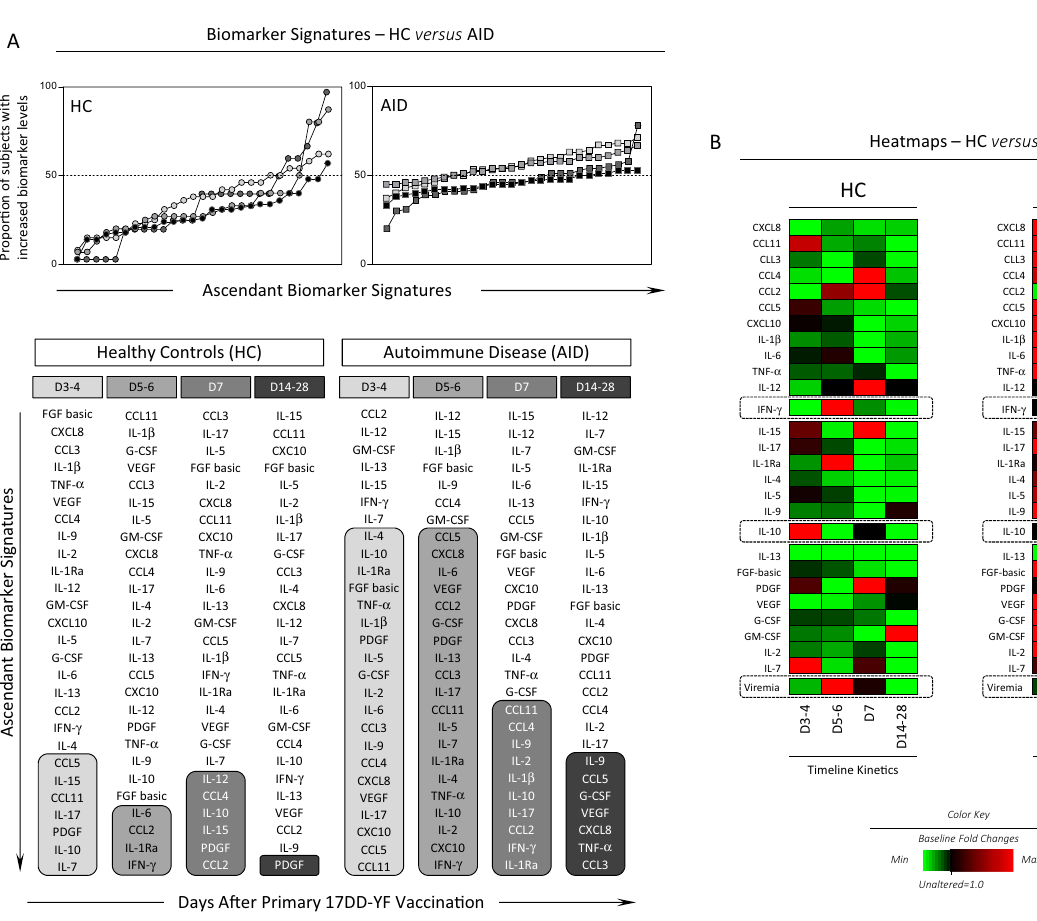
Figure 4. Serum Biomarker Signatures in Patients with Autoimmune Disease After Planned Primary 17DD- YF Vaccination. ( A ) Kinetics of serum biomarker signatures at distinct time points after primary 17DD-YF vaccination of Autoimmune Disease patients (AID, n = 140, D3–4 = light grey filled square, D5–6 = grey filled square, D7 = dark grey filled square and D14–28 = black filled circle) and Healthy Controls (HC, n = 21, D3–4 = light grey filled circle, D5–6 = grey filled circle, D7 = dark grey filled circle and D14–28 = black filled circle). The results are expressed as the proportion of subjects with increased biomarker levels (baseline fold change values > 1). Data analysis was carried out considering the 50th percentile as the reference to identify the set of biomarkers with high proportion of subjects with levels above the global median cut-off along the kinetic timeline. Those biomarkers with proportion of subjects with levels above the global median cut-off were highlighted with gray scale rectangles. ( B ) Heatmaps were constructed considering the baseline fold change values at each time point along the kinetic follow-up (D3–4, D5–6, D7 and D14–28). This approach was employed to draw the overall change in the serum biomarkers profile after primary 17DD-YF vaccination of Autoimmune Disease patients (AID, n = 140) and Healthy Controls (HC, n = 21). Data interpretation was carried out based on the color keys employed to underscore the baseline fold value = 1.0 as the reference for unaltered levels (black filled square), the baseline fold value < 1.0 for decreased levels (green filled square) and the baseline fold value > 1.0 for increased levels (red filled square), according to the paired sample collected at